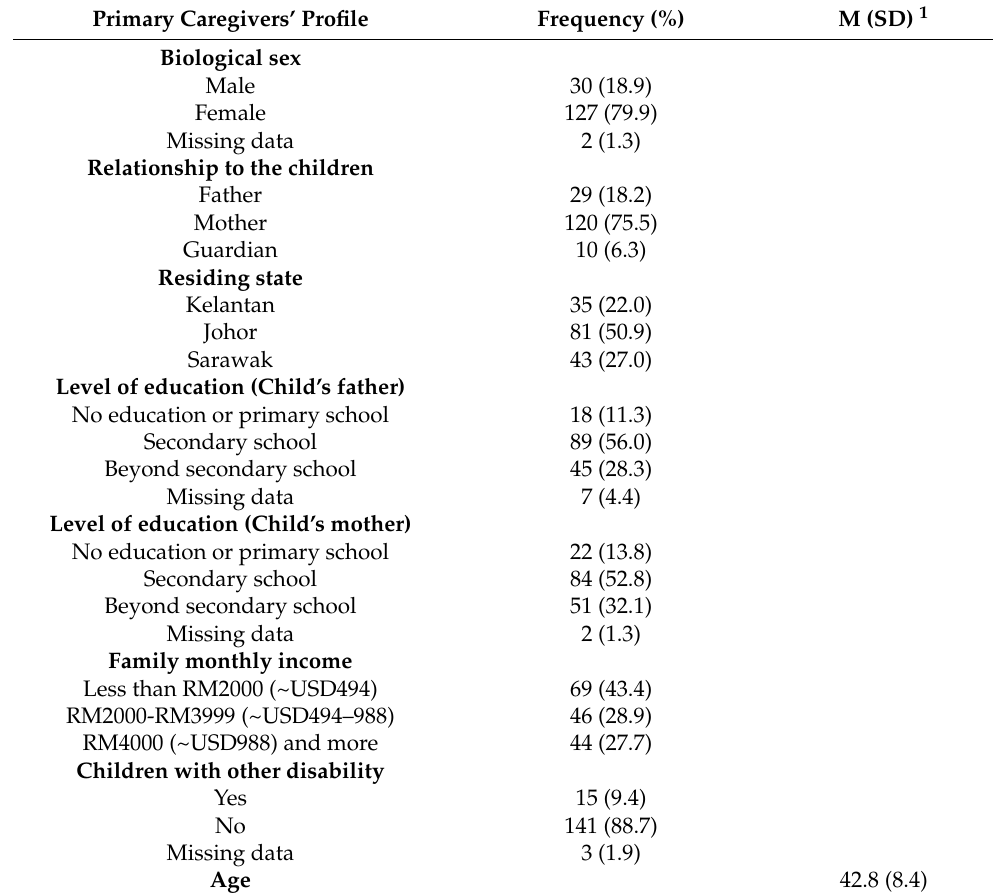
Table 1. Profile of the Primary Caregivers ( n =